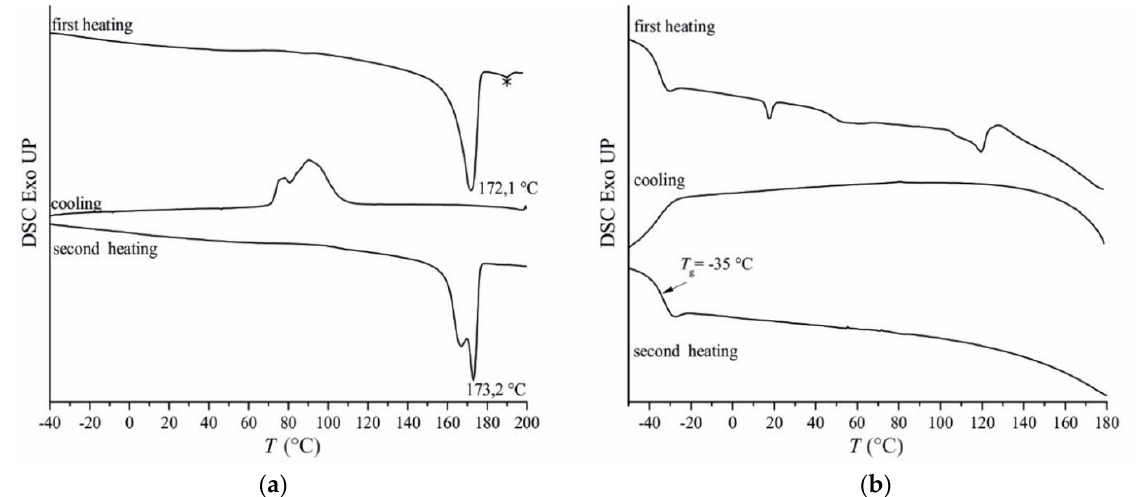
Figure 5. DSC thermograms, acquired at 10 °C/min of the EO-loaded nanoparticles PHB NPs ( a ) and PHB-HHx NPs ( b ). The melting/crystallization of residual SDS crystals is marked (*).